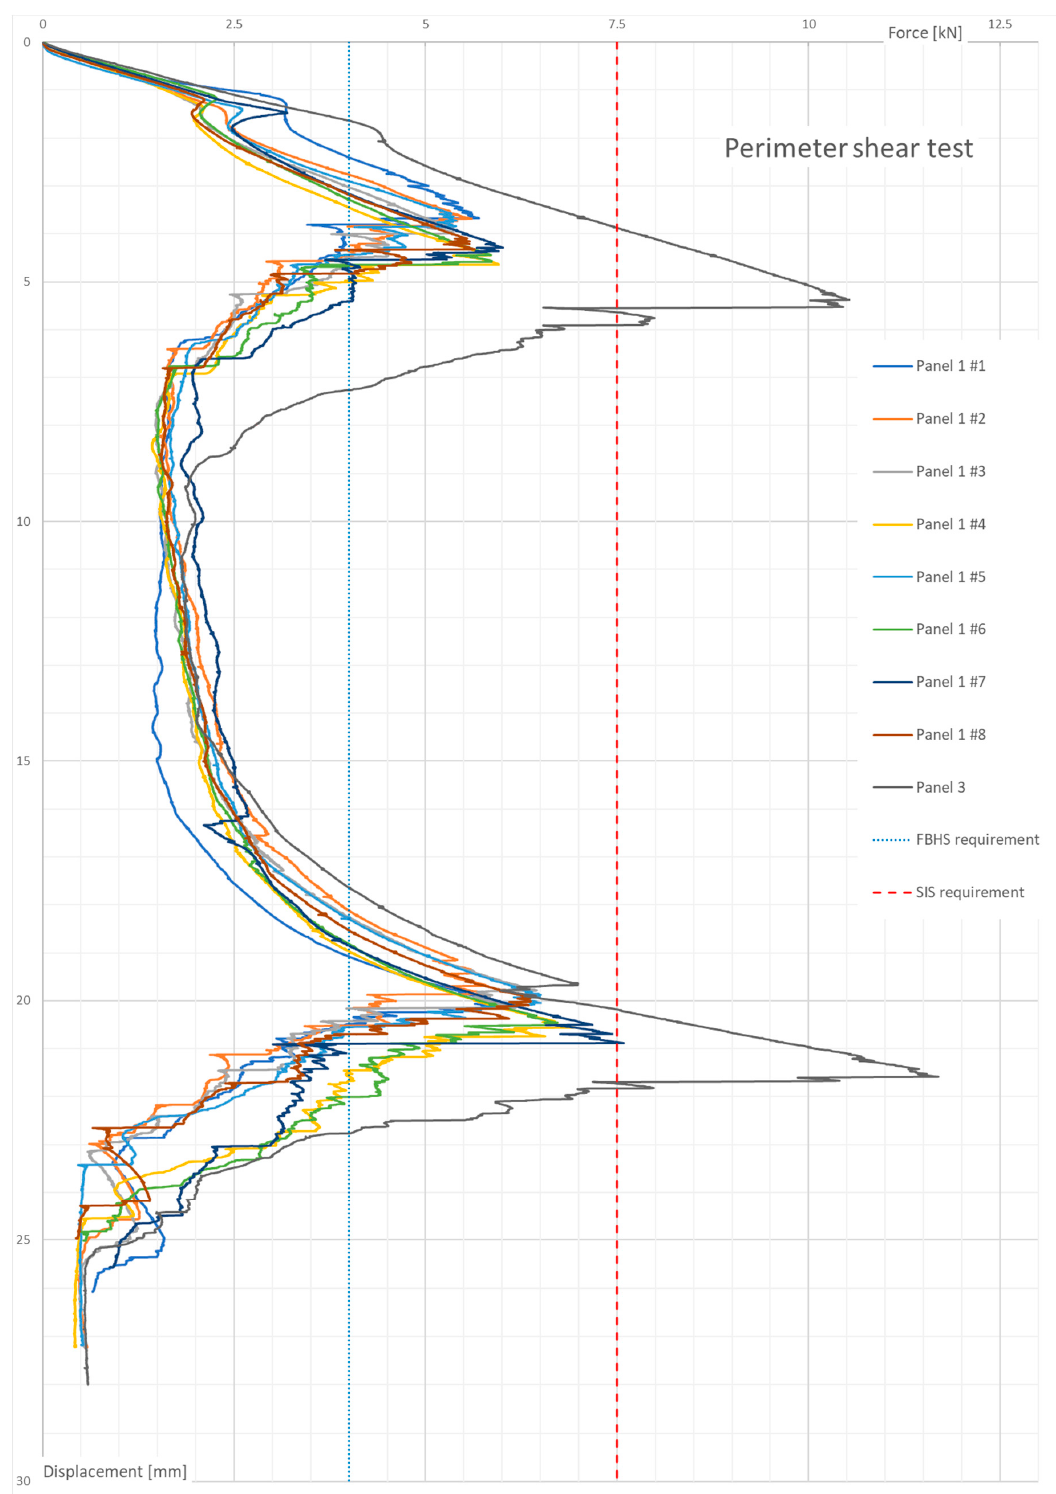
Figure 6. Perimeter shear test results.